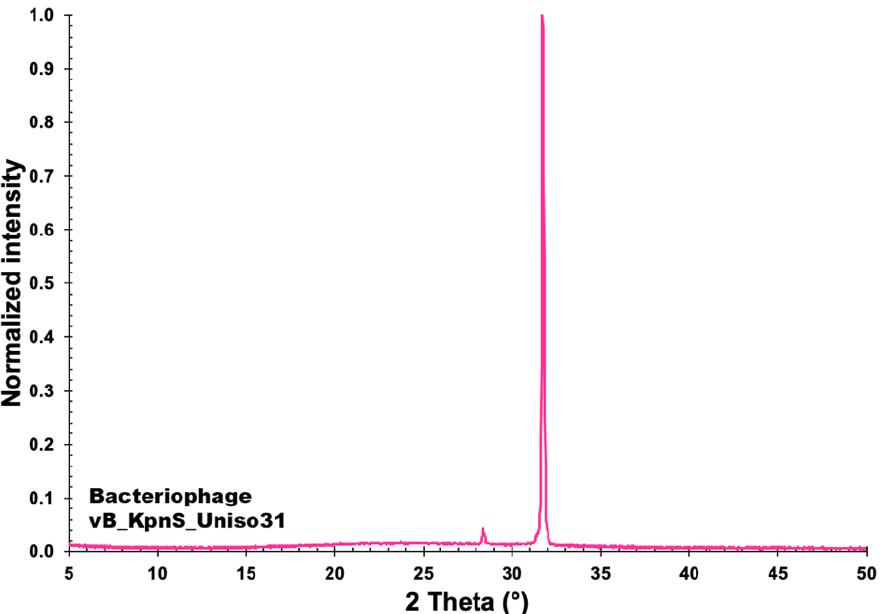
Figure 10. Normalized X-ray diffractogram (XRD) of a sample of the concentrated suspension of phage Kpn31. Diffractogram obtained at an X-ray wavelength of 1.5418 Angstrom.